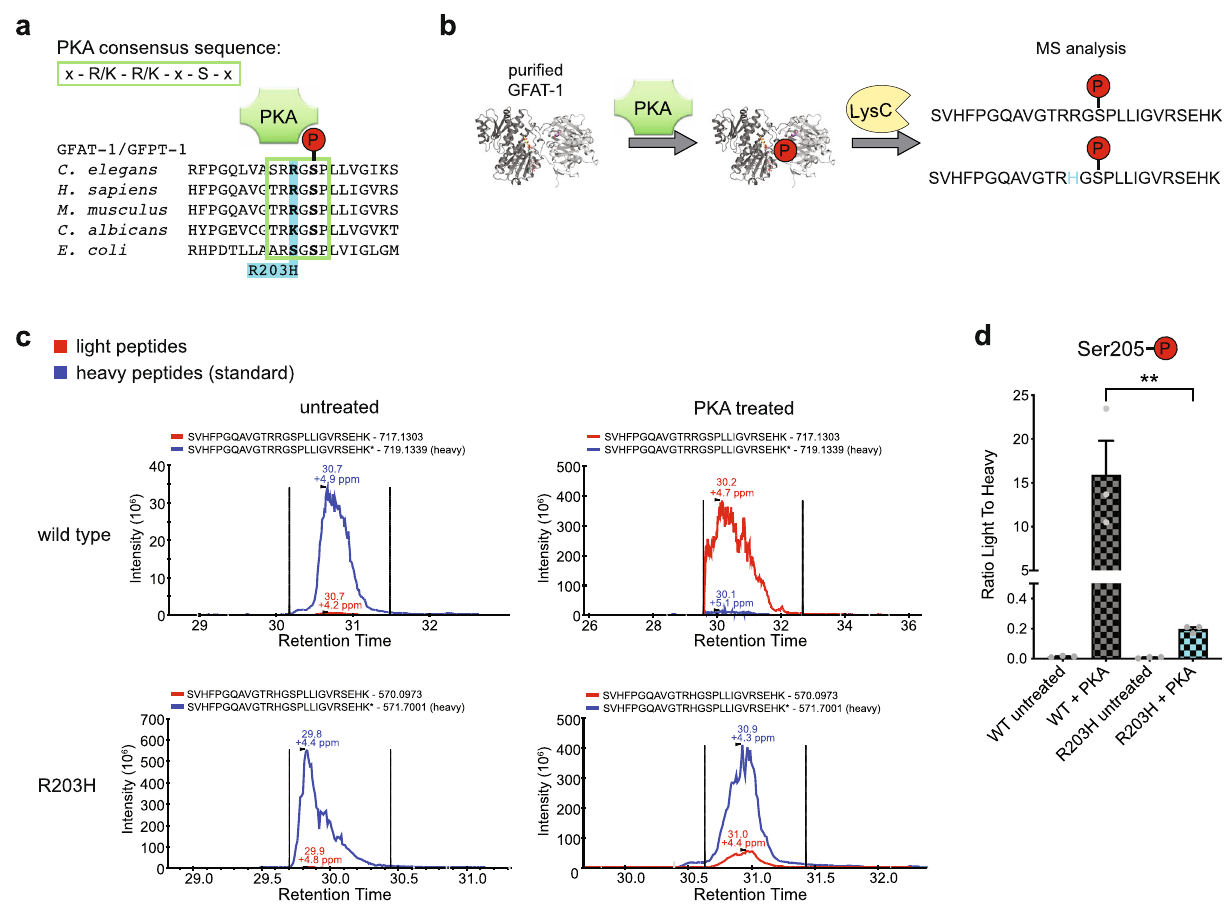
Fig. 3 The GFAT-1 gain-of-function substitution R203H disturbs PKA phosphorylation at Ser205. a Position of gain-of-function mutation R203H in a protein sequence alignment of GFAT-1. R203H (cyan) disrupts the PKA consensus sequence (green box) at Ser205. b Work fl ow for the in vitro phosphorylation analysis. c Representative quanti fi cation of the light and heavy peptides by mass spectrometry. d Quanti fi cation of the Ser205 phosphorylation of wild type (WT, gray) and R203H (cyan) GFAT-1 before and after treatment with PKA (mean + SEM, n = 4, ** p = 0.0021, one-way ANOVA). Source data are provided as a Source Data fi le.